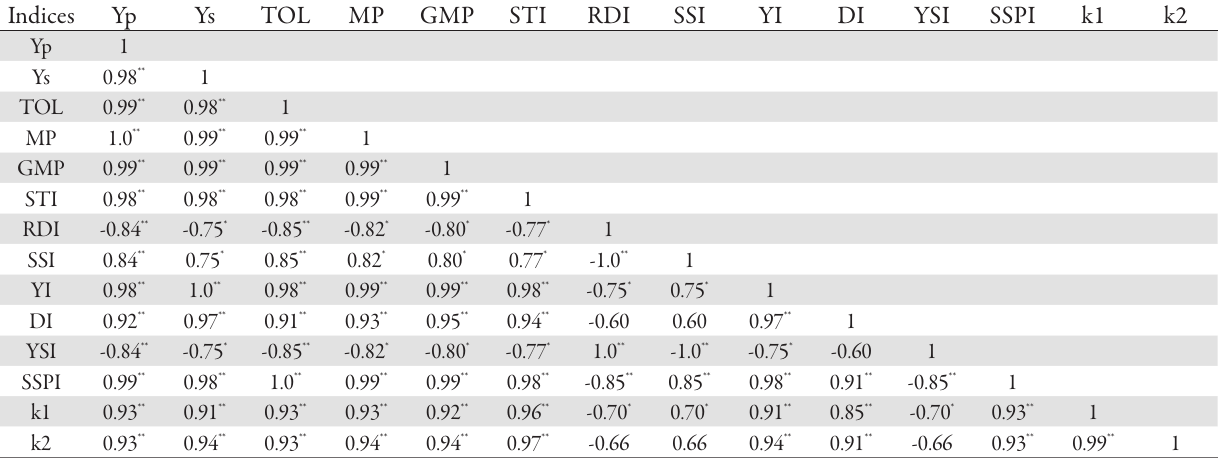
Tab. 3. Correlation coefficient between Yp, Ys and resistance/tolerance